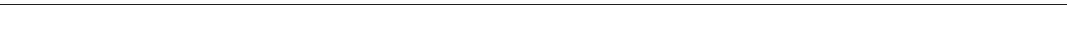
Fig. 4 Molecular and phenotypic evolution in T. pseudonana . a Principal component analysis (PCA) of evolved and ancestral lineages calculated from distance matrices based on single-nucleotide variants (SNVs) in protein-coding regions that had reached fi xation after 300 generations of evolution. b PCA of phenotypic traits calculated from the change in each trait measured at the treatment temperature relative to that expressed in the ancestor at the same temperature. In panels a , b colors indicate the selection regime with black for the ancestor, green for 22 °C, blue for 26 °C, red for 32 °C, and purple for the fl uctuating regime. The ellipses in PCAs give the 95% con fi dence interval around the centroid and thus give an idea of whether the treatments differ signi fi cantly (detailed information on the statistical signi fi cance of separation of the selection environments can be found in Table 1 & Supplementary Tables 12 and 13). c Estimated allele frequencies for 1703 single-nucleotide variants that putatively reached fi xation in at least one t300 population. Of these, 1689 are missense, and 14, stop-codon variants. The color of each cell in the heat-map indicates the estimated allele proportion in the population, based on the ratio of variant sequence reads versus total read depth at that genomic site. Homozygously fi xed alleles will appear as yellow or red (allele proportion zero or one, respectively), heterozygously fi xed alleles as orange. The side-bar indicates the selection regime with colors as stated